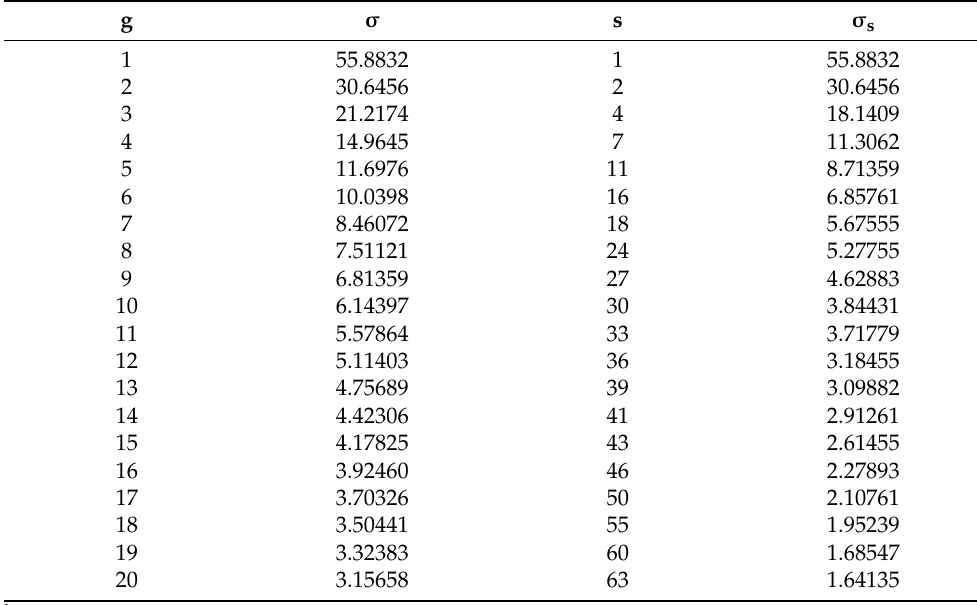
Table 1. Characteristics of optimal and superpixel approximations 1